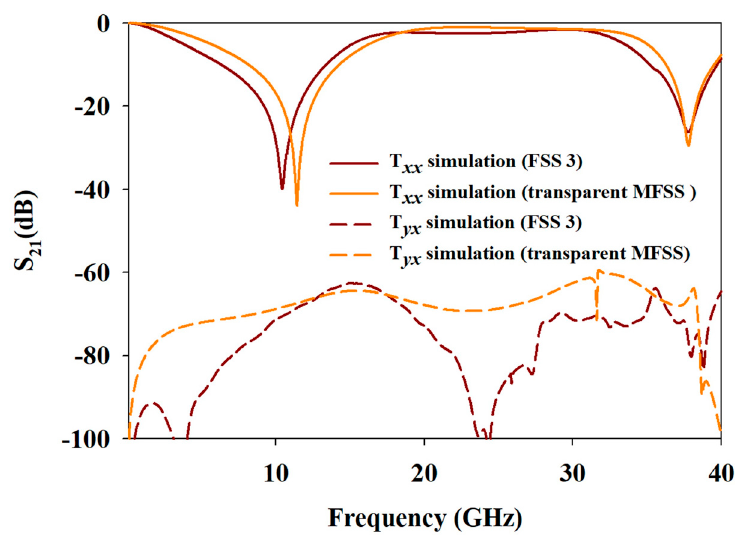
Figure 11. The simulated T (cid:3051)(cid:3051) and T (cid:3052)(cid:3051) of FSS 3 and transparent MFSS.